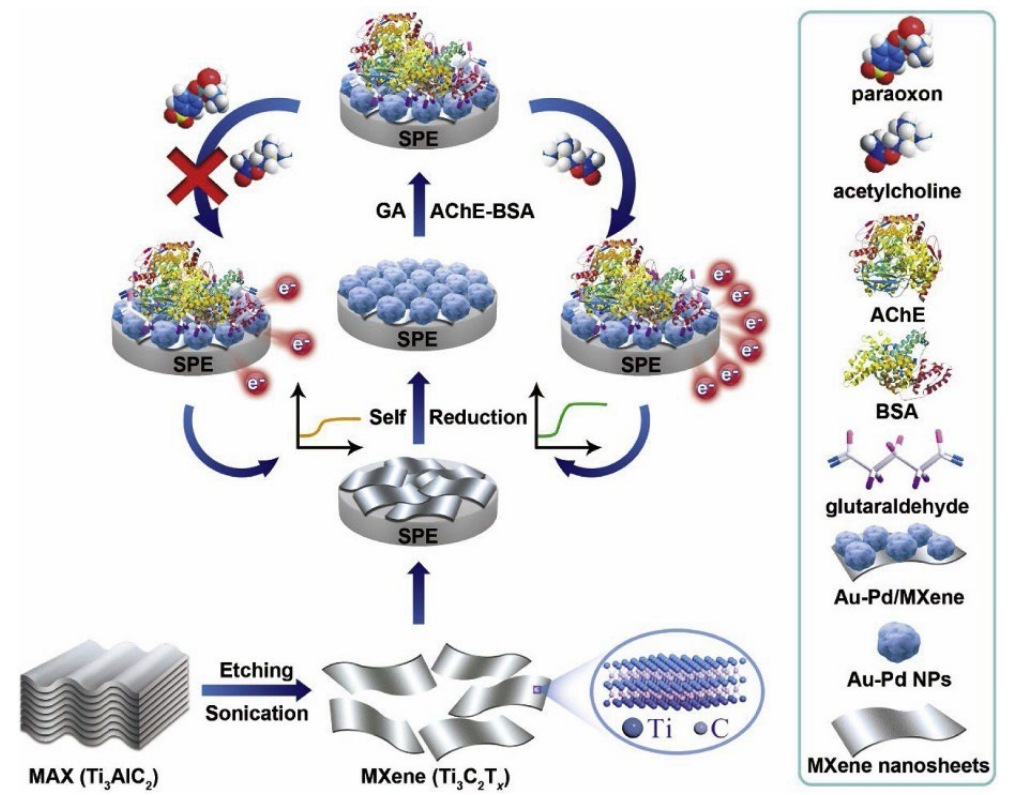
Figure 4. TMX synthesis and biosensor fabrication via covalent immobilization of ACLE. Reproduced with permission from [100].